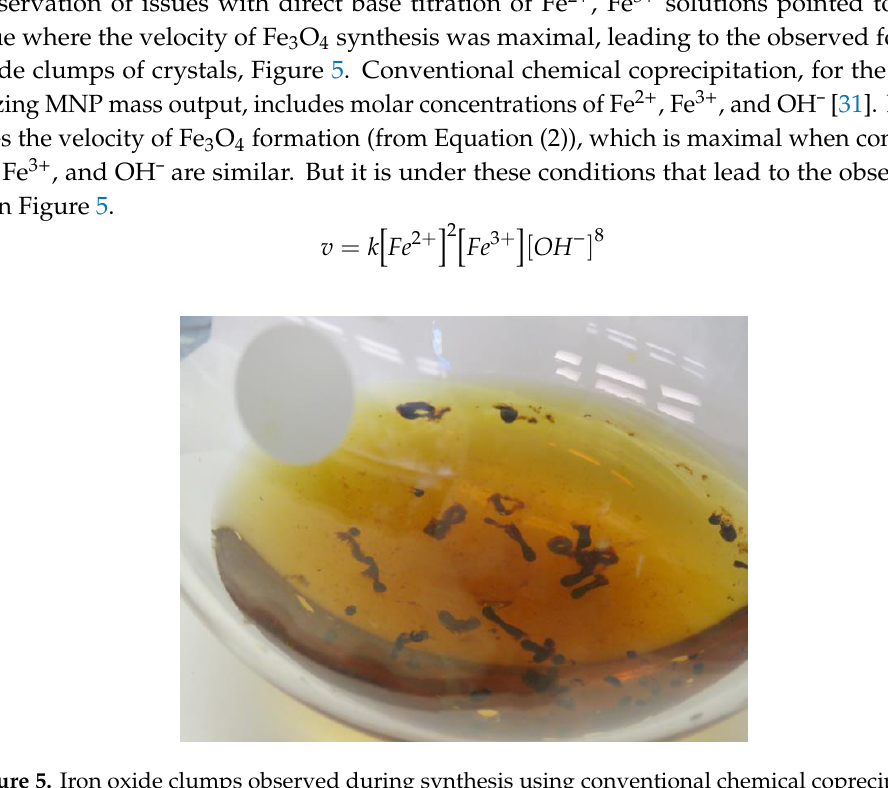
Figure 4. Synthesis progression of an iron salt solution (3.8 mM ∑Fe and 2:1 Fe 2+ :Fe 3+ ) with 3.3% (v/v) NH 3(g) after (a) 2 min, insert photo is starting Fe 2+ :Fe 3+ salt solution, (b) after 15 min, (c) at 90 min, and (d) nanoparticles drawn to the magnet on the side of reaction vessel. Diffusion coefficients for Fe 2+ and Fe 3+ are 7.19 × 10 −6 cm 2 /s and 6.04 × 10 −6 cm 2 /s (NTP), respectively, and is 52.7 × 10 −6 cm 2 /s for OH¯ 35.